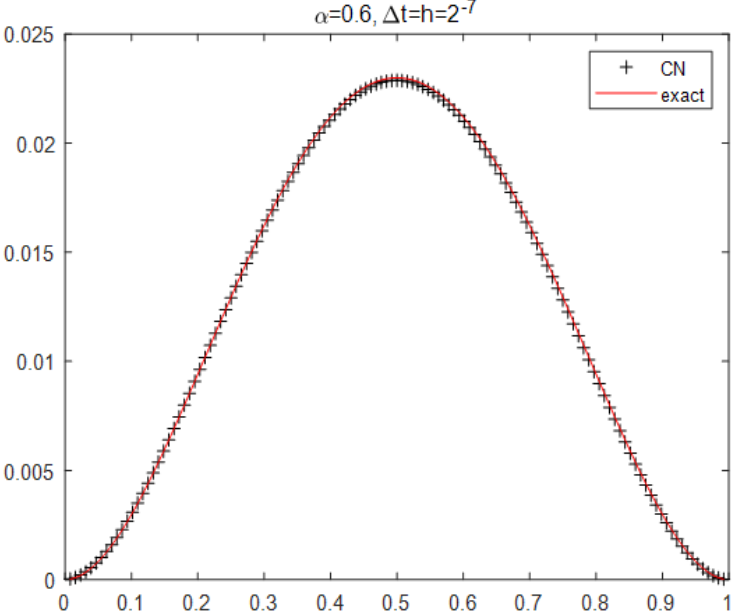
Figure 7. The numerical solution for the Crank-Nicolson scheme and exact solution for Example 2 with α = 0.6, ∆ t = h = 2 − 7 at time T =